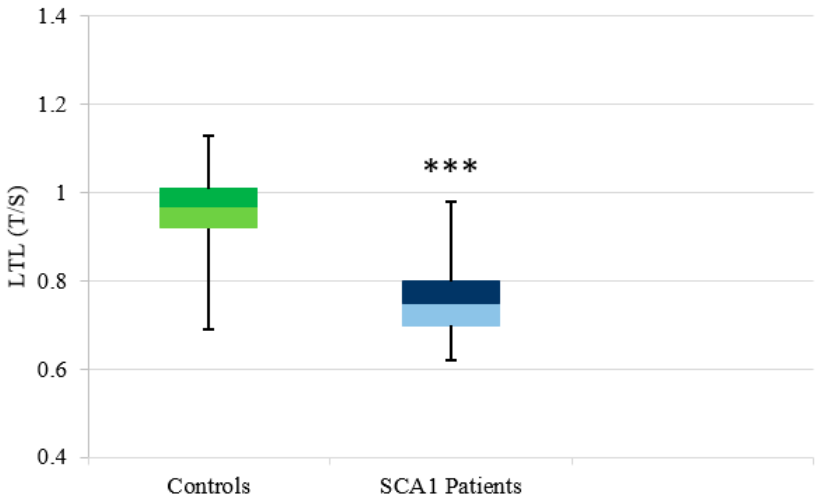
Figure 1. Distribution of LTL in controls and SCA1 patients. Box plot showing the distribution of LTL expressed as a relative telomere length T/S ratio (the number of copies of telomeric repeats T compared to a single copy gene S) used as a quantitative control. Comparison between control subjects, n = 104 (median: 0.97, Q1: 0.92, Q3: 1.01), and SCA 1 patients, n = 52 (median: 0.75, Q1: 0.70, Q3: 0.80), showed highly significant value (*** p <